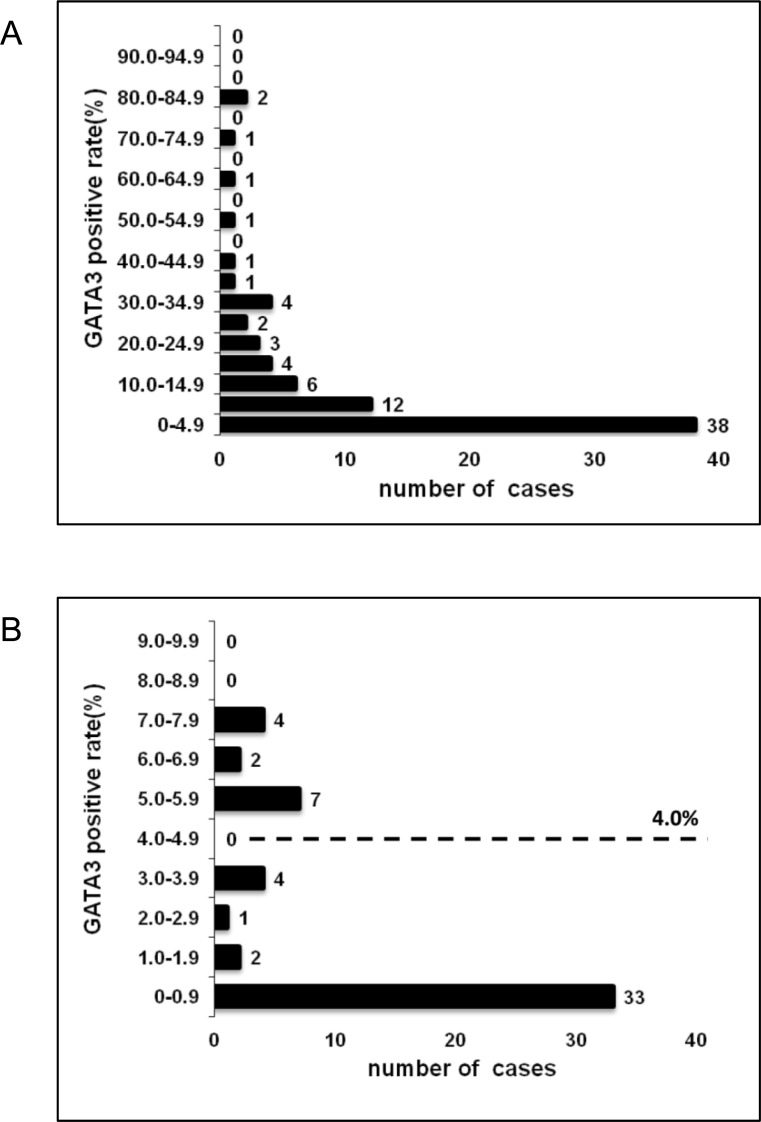
The distribution of GATA3 positive rate in soft tissue sarcomas.(A) The histogram of the GATA3 positive rate shows skewed distribution in all cases. (B) The histogram of GATA3 which focuses the percentage from 0 to 10 with the longitudinal axis by every 1 percent.